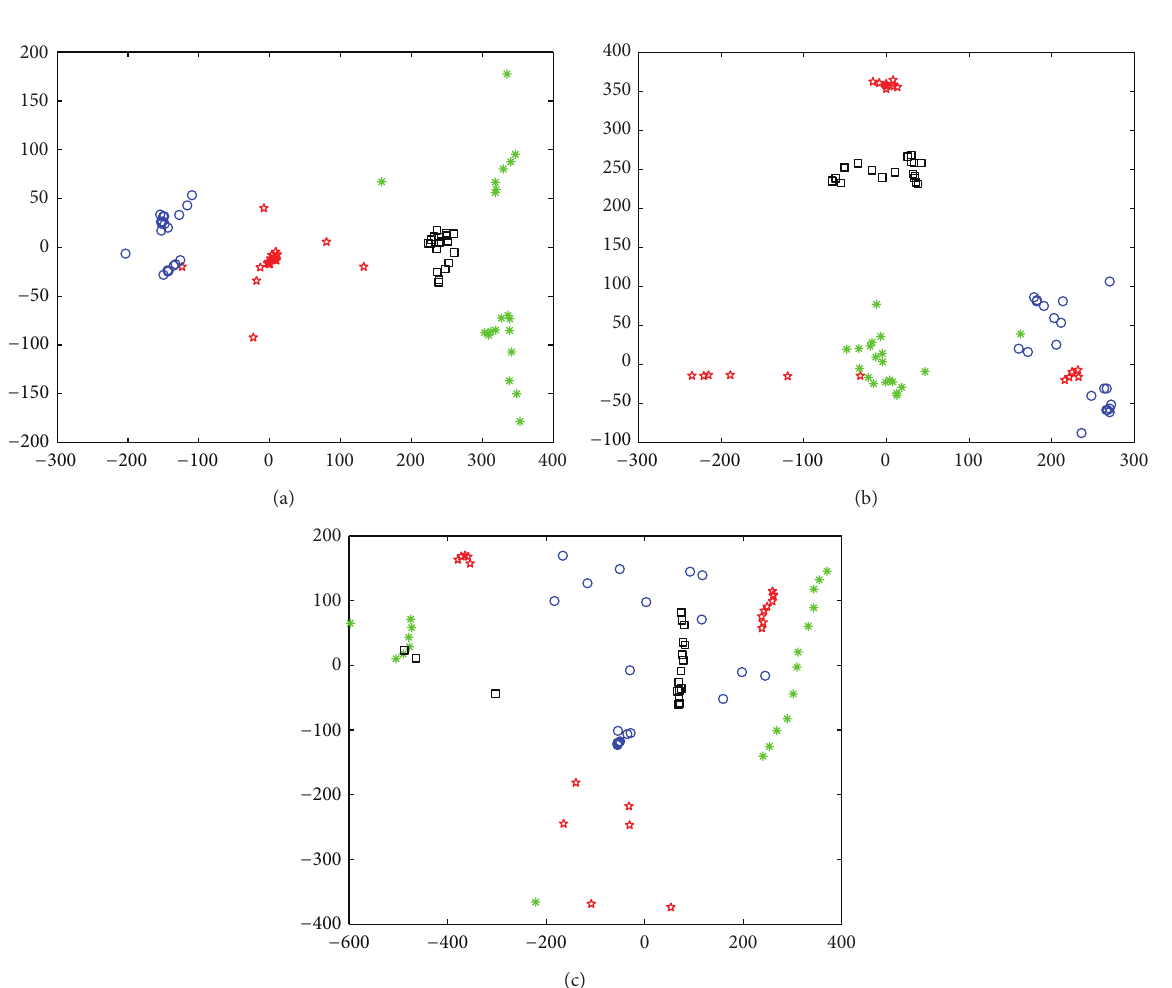
building images may be taken from various viewpoints, and images may have different scaling and illumination condi- tions, and there may exist occlusion and rotation